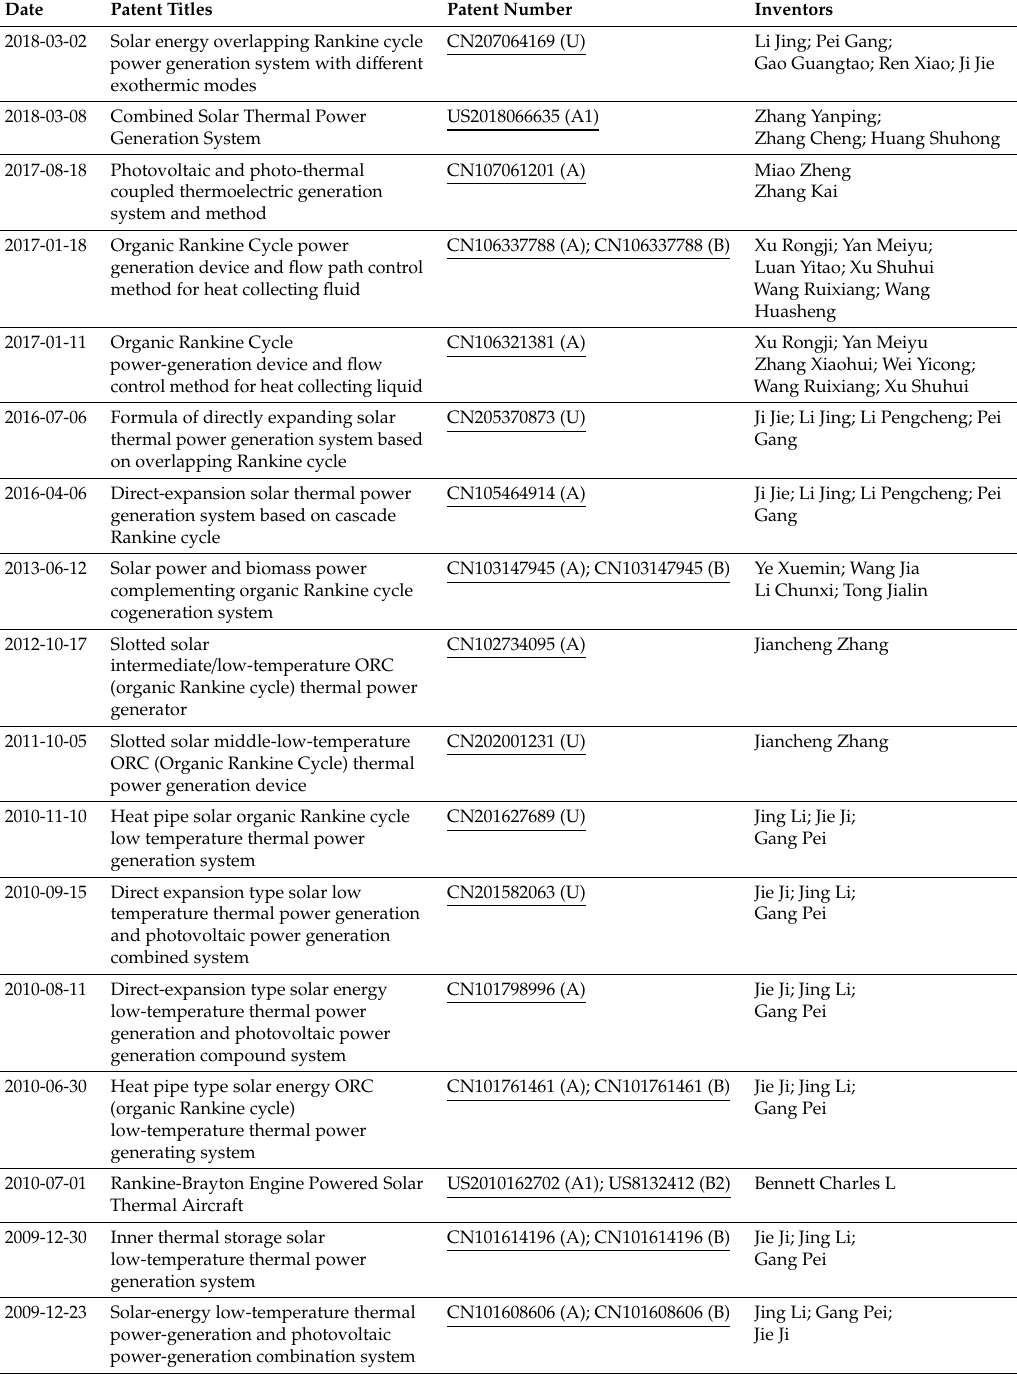
Table 2. Patent updates on organic Rankine cycle (ORC) system applications for solar